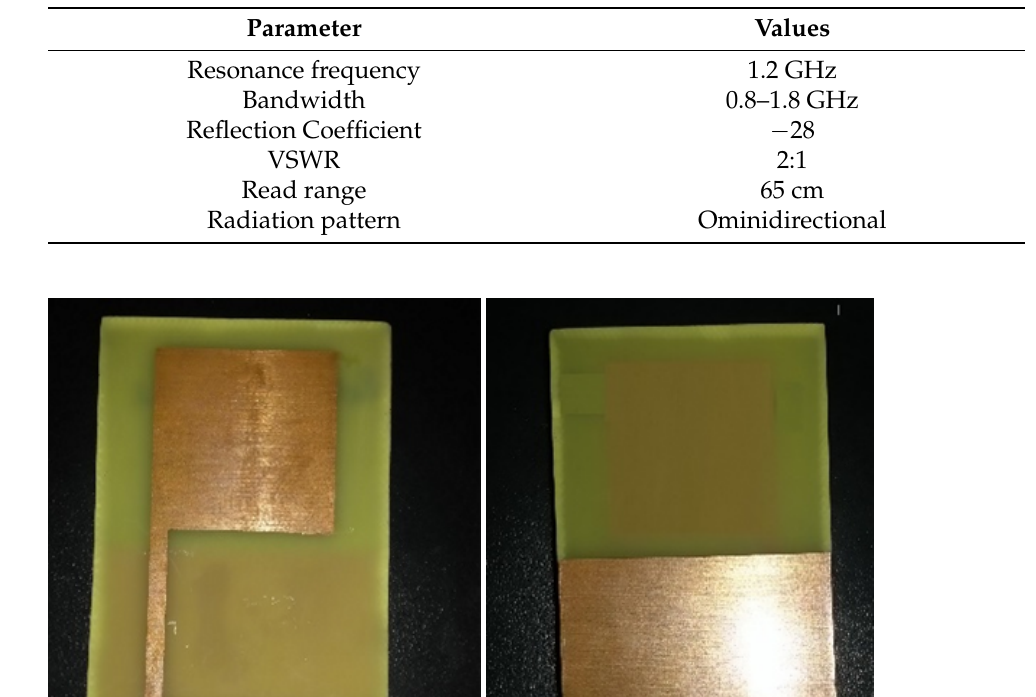
Table 5. Transmitter and receiver antenna characteristics of RFID tag.